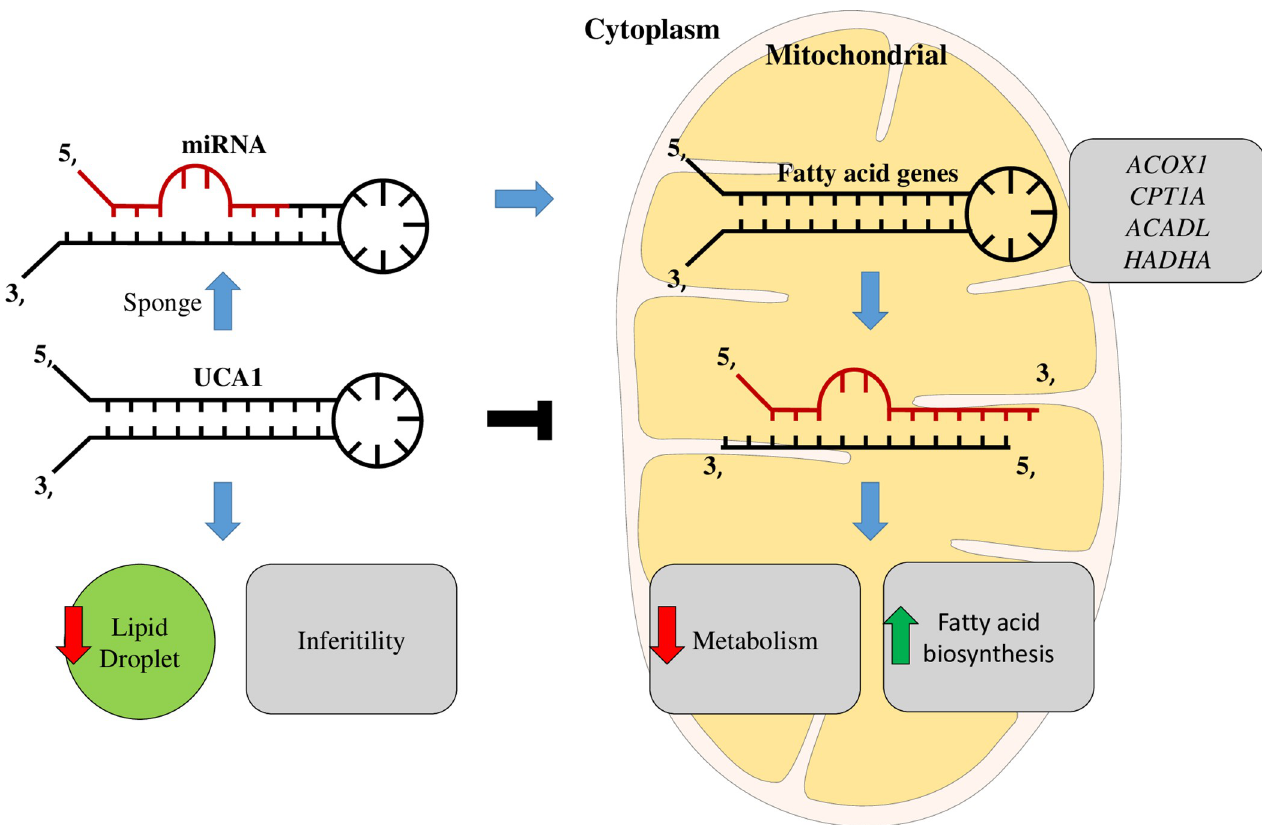
Fig 8. Proposed pathogenesis model in the development of endometriosis and the associated infertility based on the findings of this study. Elevated UCA1 in endometriosis patients via RNA stabilization by functional SNPs can disrupt lipogenesis regulation by sponging key miRNAs with target genes involved in lipid metabolism. Such epigenetic regulation can further lead to reduced biosynthesis of triacyglycerol for oocyte future maturation and increased lipotoxicity, resulting in infertility.